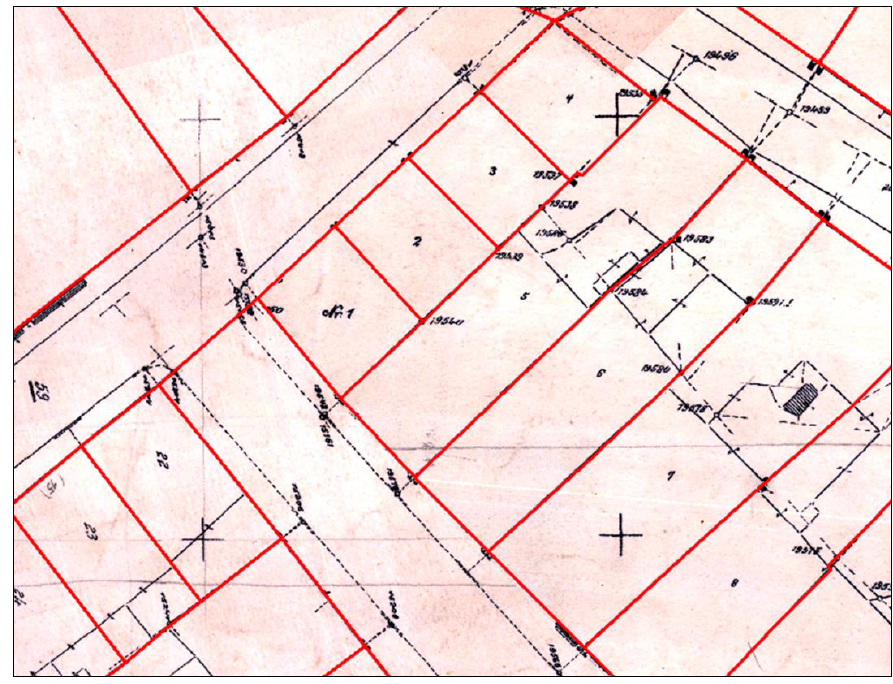
Figure 7. A fragment of the cadastral map of Toru´n showing vectorised plot boundaries (red). Source: own work based on Gemarkungskarte der Stadt Thorn, Blätter 43, 44, 45, State Archives in